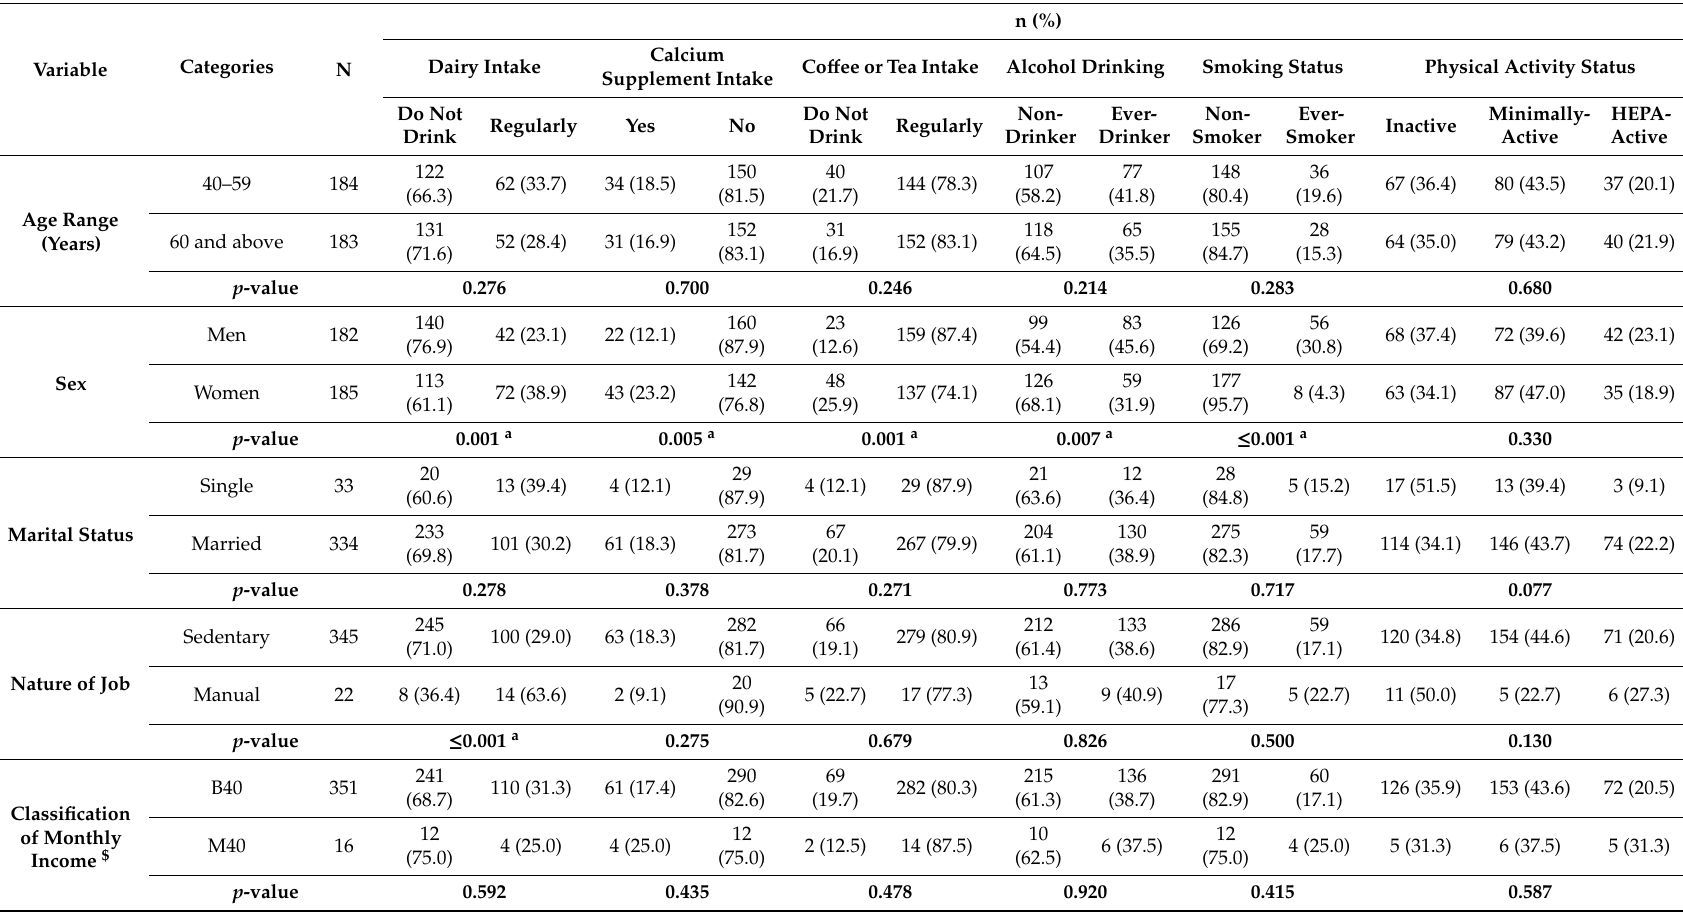
Table 4. Comparison of dietary and lifestyle practices with socio-demographic